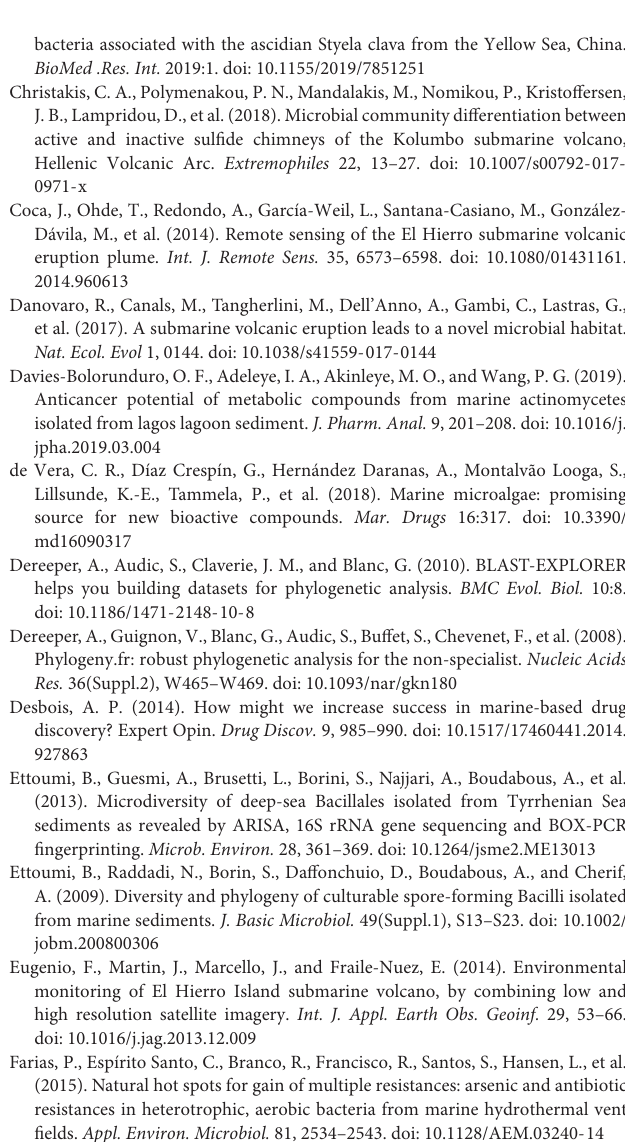
secondary crater (DA04–06), sampling data, and